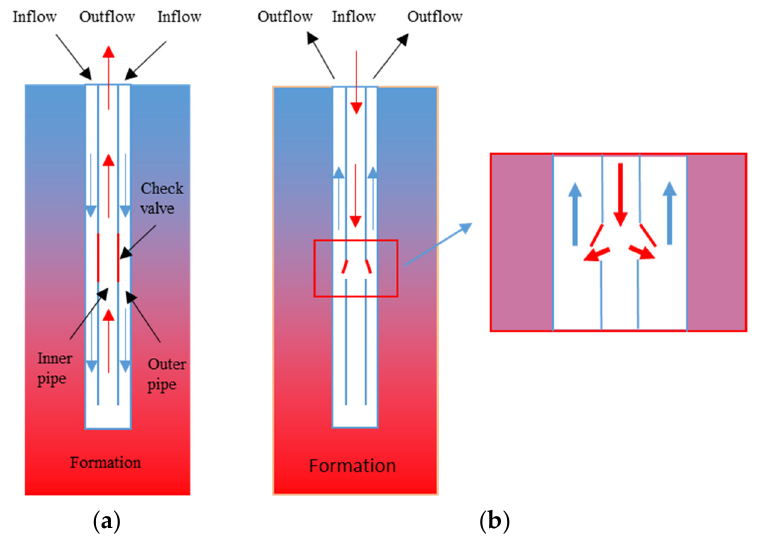
Figure 1. Schematic diagram of the novel DBHE system, ( a ) winter operation mode, ( b ) summer operation mode.